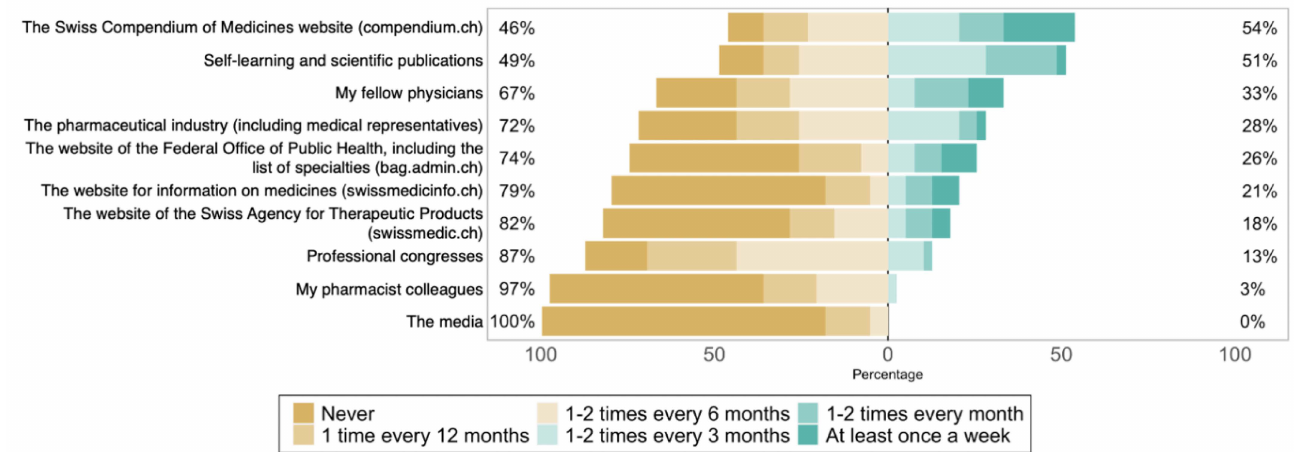
Figure 2. Participants’ answers to each item in the question “In the past 12 months, how often have you used the following sources of information regarding biosimilars?” ( n = 37).